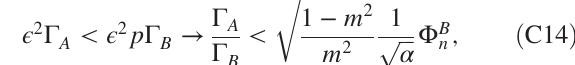
p L . In Figs. Þ Γ B